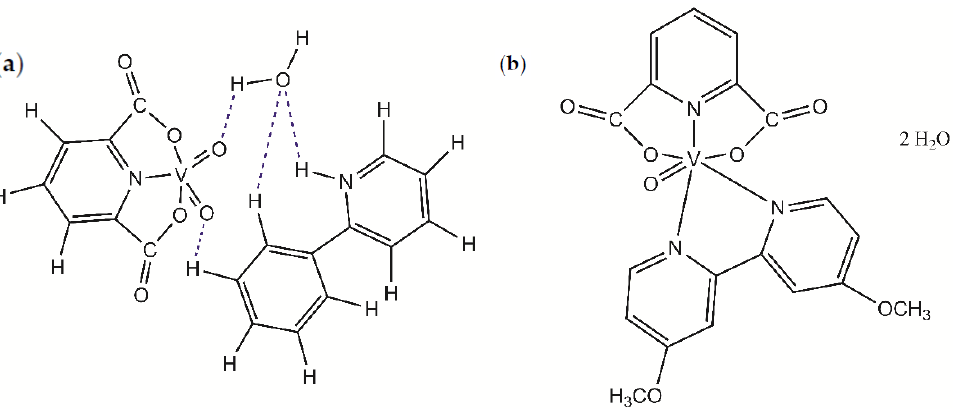
Figure 1. Molecular formulas of ( a ) [VOO(dipic)](2-phepyH) · H 2 O and ( b ) [VO(dipic)(dmbipy)] · 2 H 2 O. The compound [VOO(dipic)](2-phepyH) · H 2 O was obtained as crystals, while com- pound [VO(dipic)(dmbipy)] · 2 H 2 O was obtained as a powder. All crystal